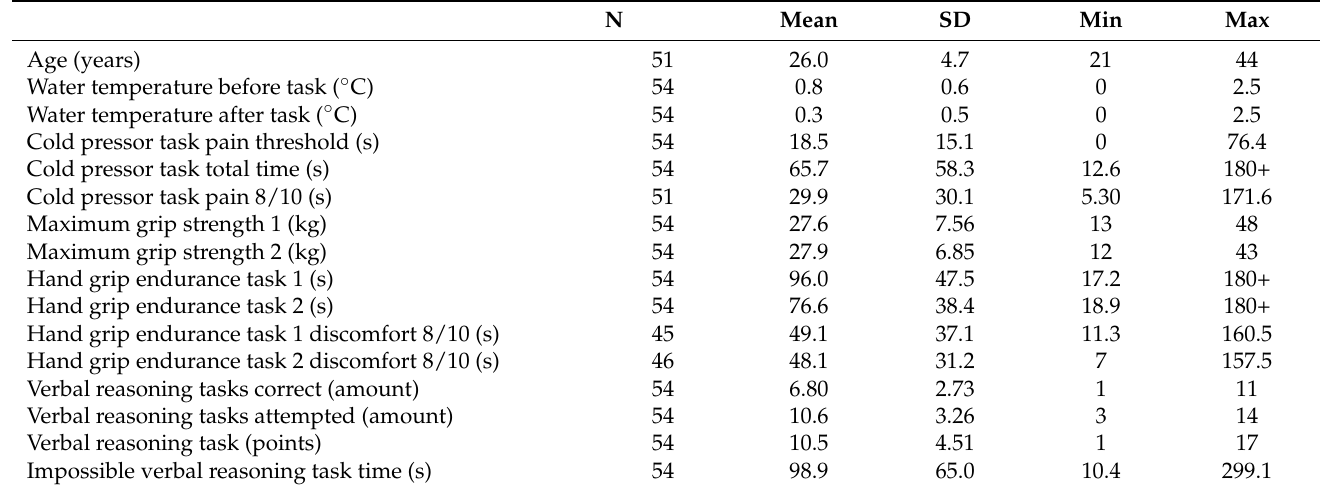
Table 1. Descriptives (Note: some of the respondents failed to report their age. Some of the respondents never reported discomfort or pain levels of